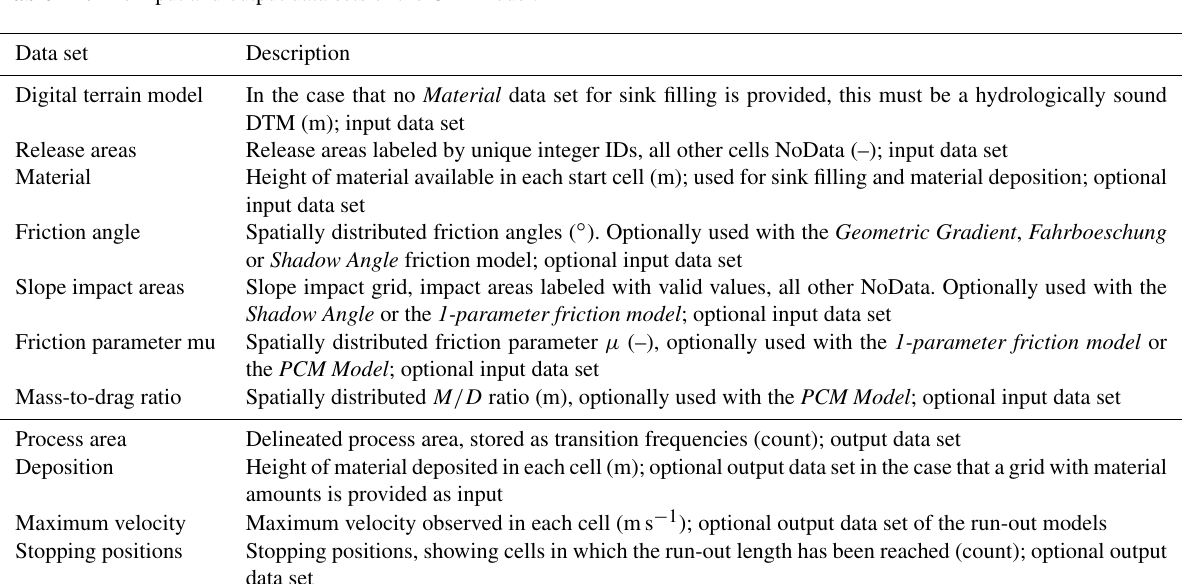
Table A4. The input and output data sets of the GPP